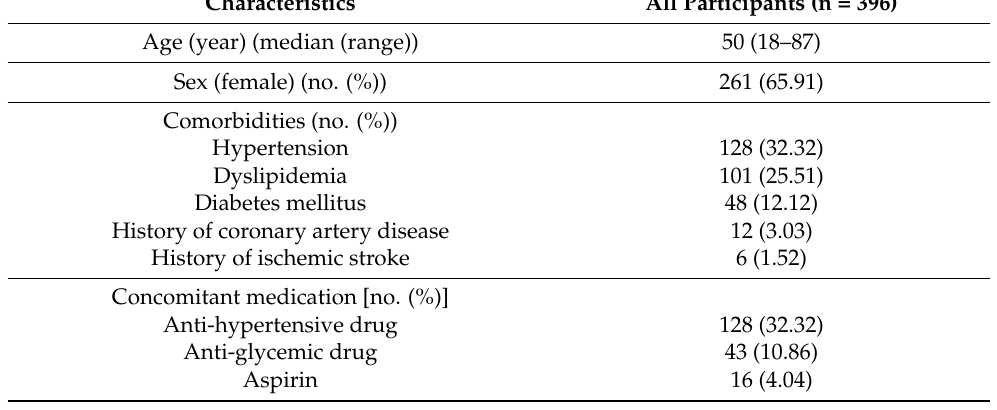
Table 1. Demographic data and clinical characteristics of participants.